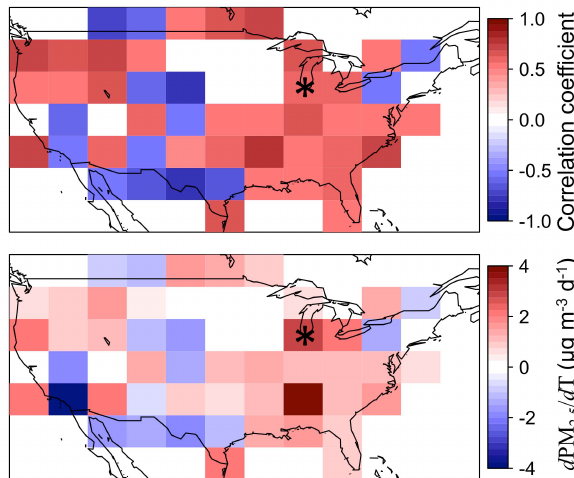
Fig. 2. Interannual correlation of annual mean PM 2 . 5 with the pe- riod T of the dominant meteorological mode for 1999–2010 ob- servations: correlation coefficients (top) and reduced-major-axis re- gression slopes dPM 2 . 5 /dT (bottom). Only values significant with 90% confidence (p-value < 0.1) are shown. The asterisk marks the Chicago grid cell for which the time series of PM 2 . 5 and T are shown in Fig.